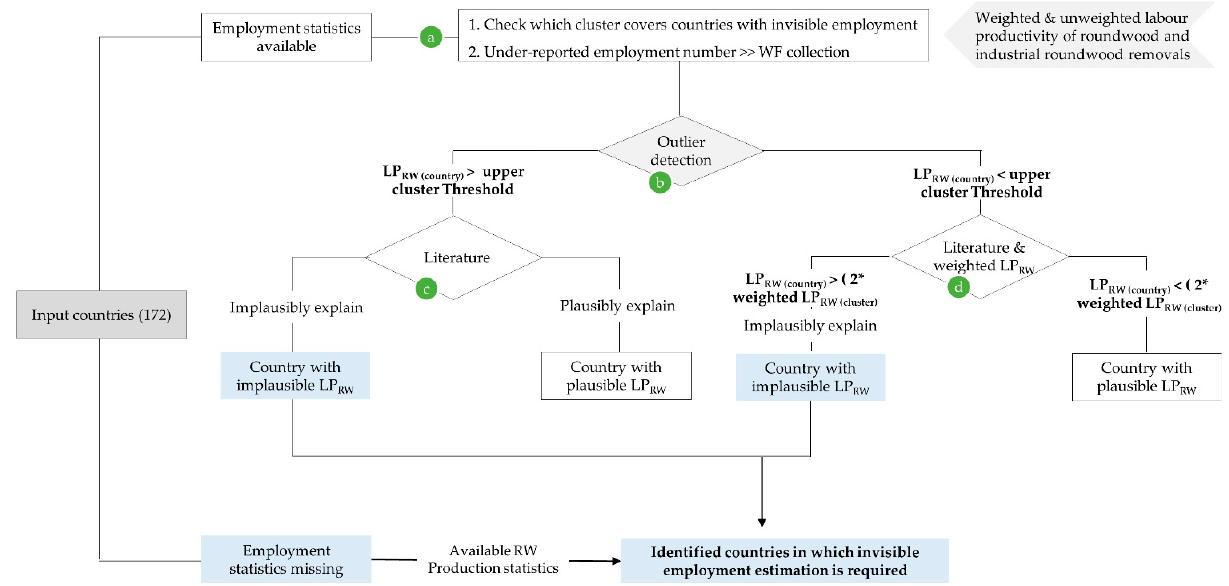
Figure 2. Decision process of identifying countries for invisible employment estimation. Note: LP RW (country) and weighted LP RW (cluster) denote labour productivity of roundwood removals of individual country and weighted labour productivity of roundwood at the cluster level, respectively. Letter a, b, c and d indicate the consecutive step of identifying country cases. * denotes multiplication.